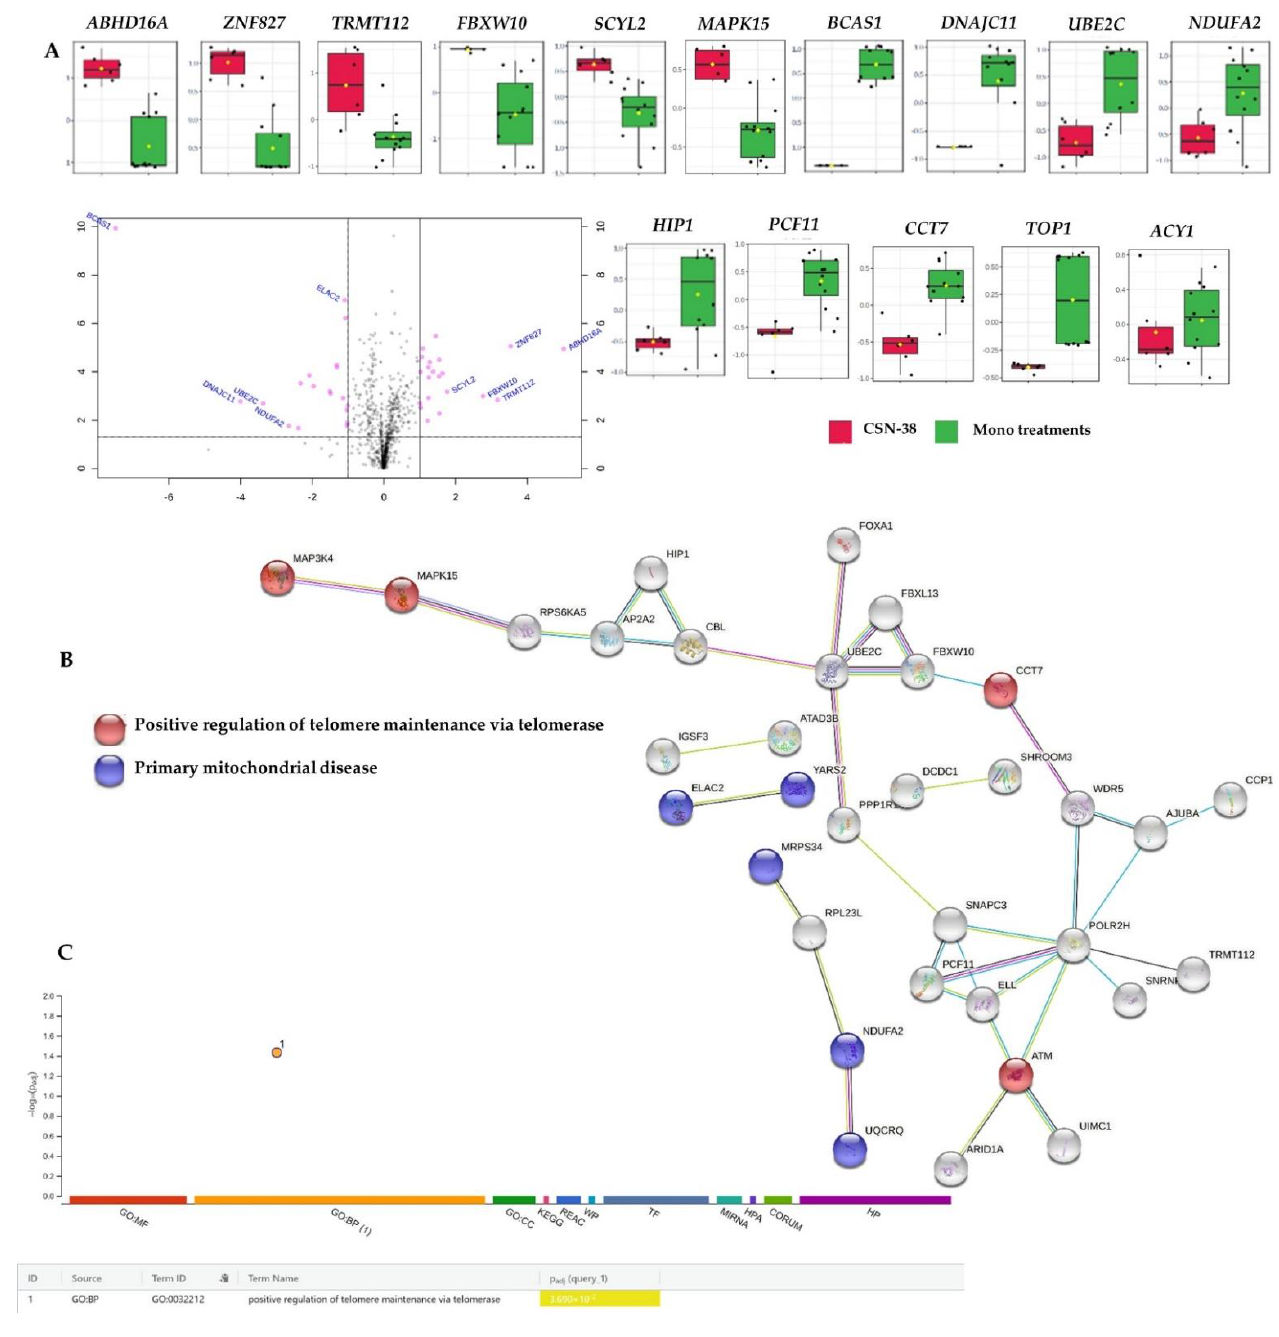
Figure 8. Differentially expressed proteins in synergistic CBD and SN − 38 combination-treated MCF7 cells (CSN − 38) compared to the monotherapies, and the corresponding overrepresented pathways. ( A ) Volcano plot with an absolute log2 fold change ≥ 1 and p -value ≤ 0.05 cutoff of the identified proteins in the CSN − 38-treated cells, together with the selected proteins’ expression summary compared to the monotherapies. ( B ) STRING network of the 91 differentially expressed proteins (fold change ≥ 2; p and Q values ≤ 0.05). The minimum required interaction score was 0.40 (medium confidence), and red, green, blue, purple, light blue, and black interaction lines indicate the presence of fusion, neighbourhood, co- occurrence, experimental, database, and co-expression evidence, respectively. The disconnected nodes were hidden in the network. ( C ) Overrepresented pathways using g:Profiler for the differentially expressed proteins (fold change ≥ 2; p and Q values ≤